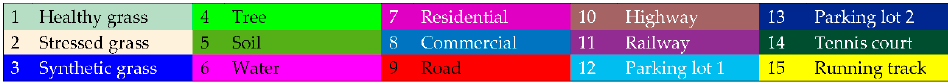
Figure A5. KMSD classification maps.